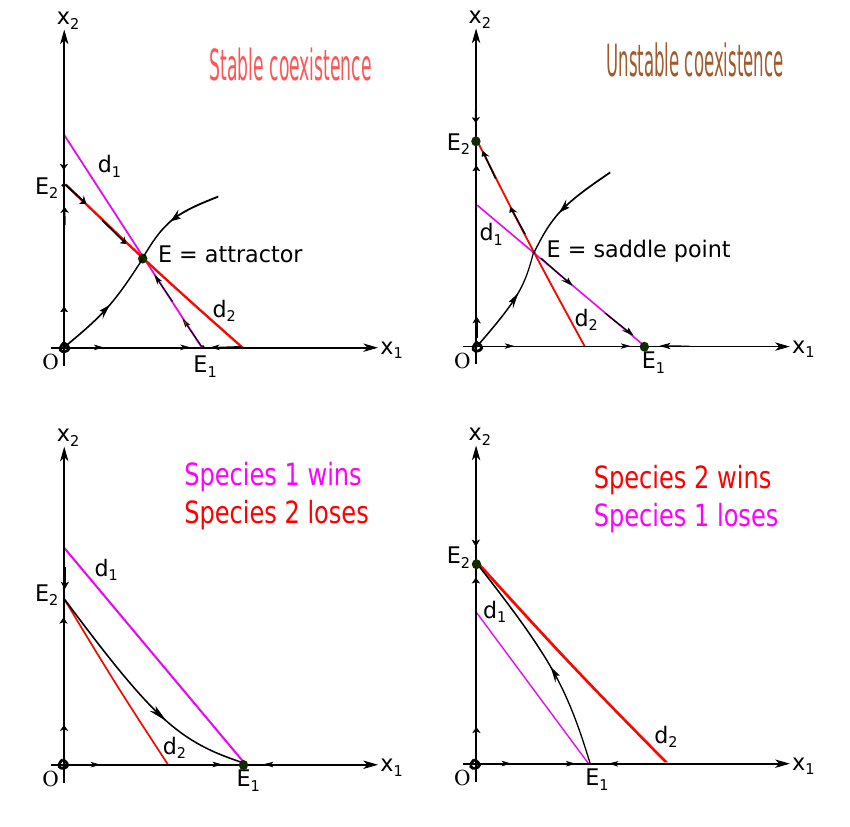
Figure 1: The four distinct phase portraits for 2-dimensional competitive Lotka-Volterra sys-